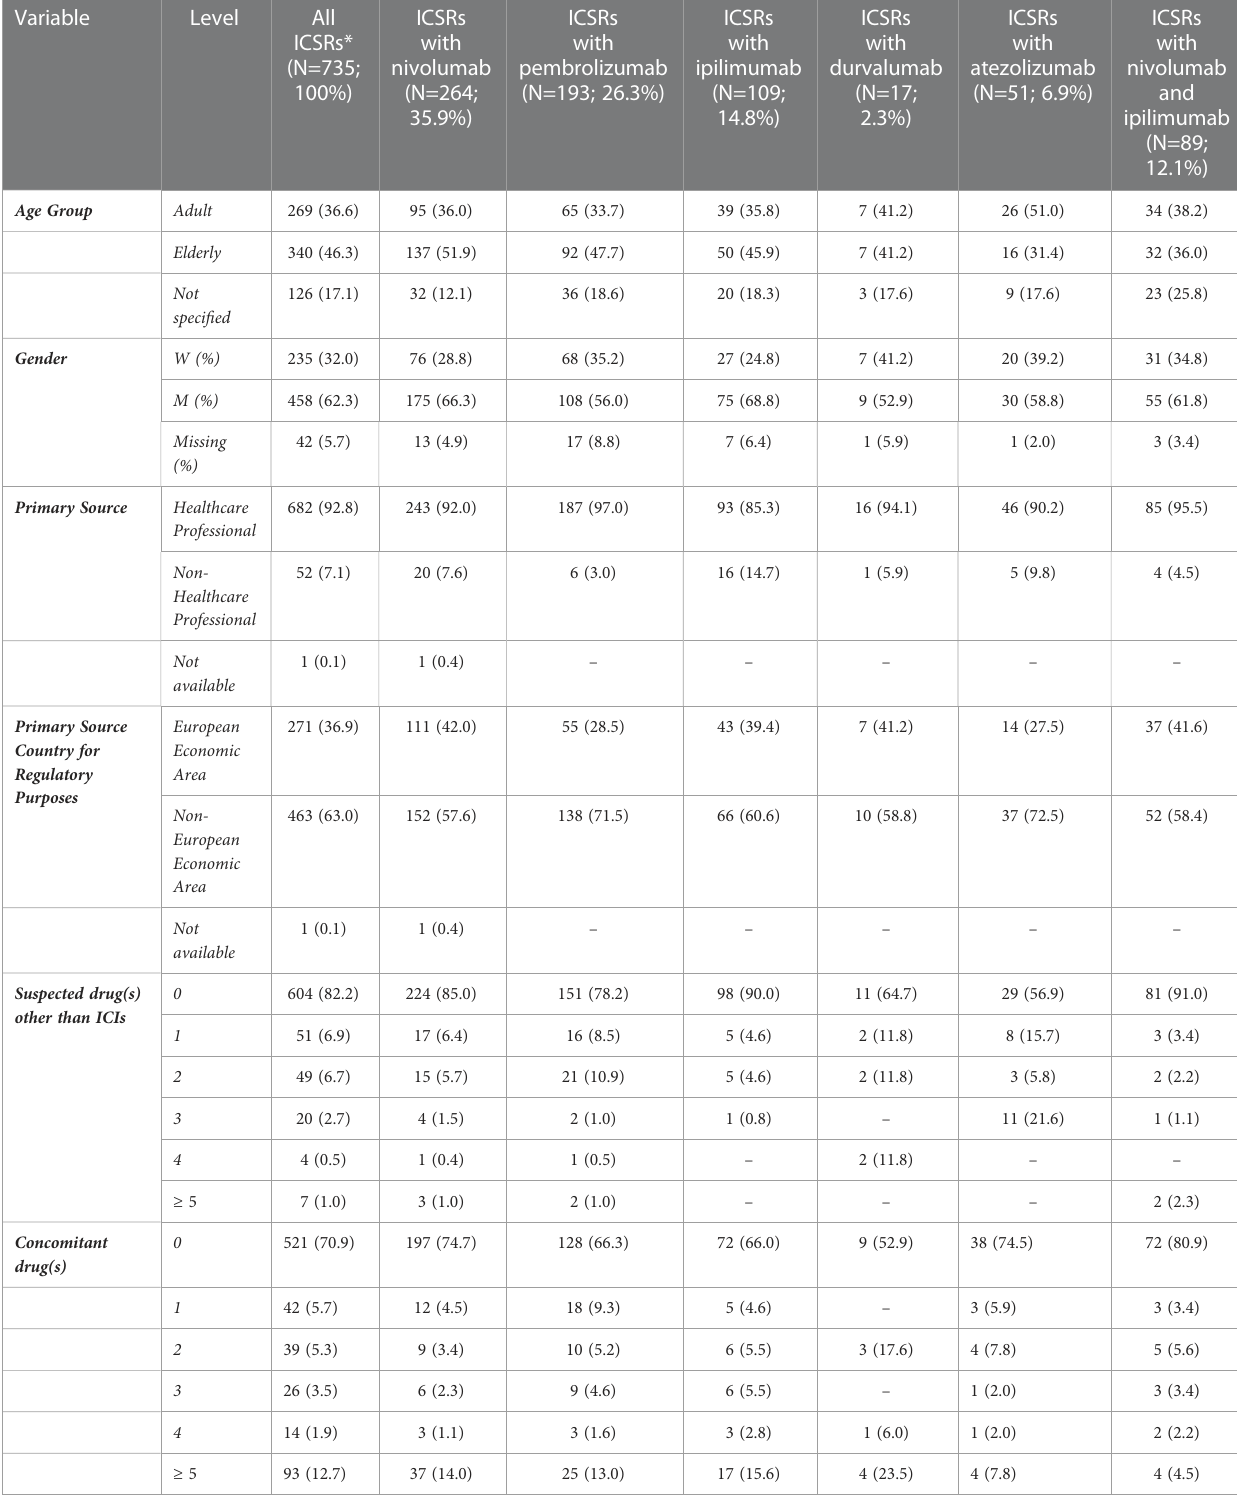
TABLE 1 Demographic characteristics and distribution for primary source, country of primary source, number of suspected drugs other than immune checkpoint inhibitors (ICIs), and number of concomitant drugs of Individual Case Safety Reports (ICSRs) reporting at least one peripheral nerve adverse event and having at least one ICI as suspected drug. Data collected in Eudravigilance from the date of each ICI marketing authorization up to